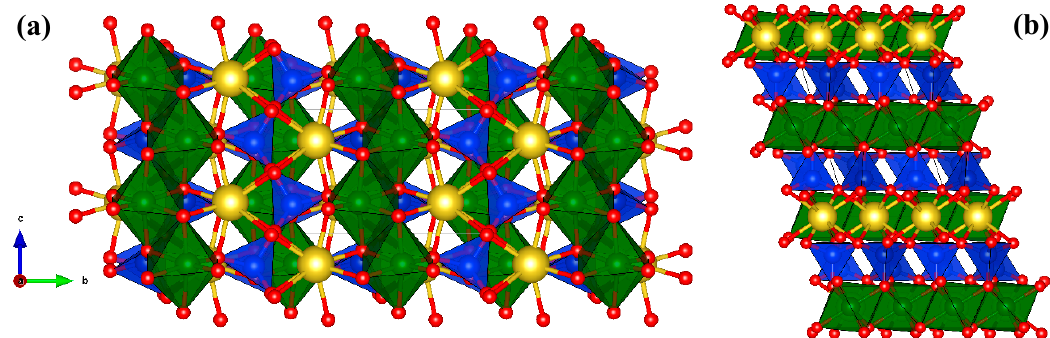
Figure 6. Polyhedral projection of the crystal structure of synthetic aegirine, as refined from the powder X-ray data of the sample, synthesized at 200 °C and sintered at 900 °C for 24 h: ( a ) viewed along the a -axis, ( b ) viewed along the b -axis. The data are available for display as Supplementary Material S2.